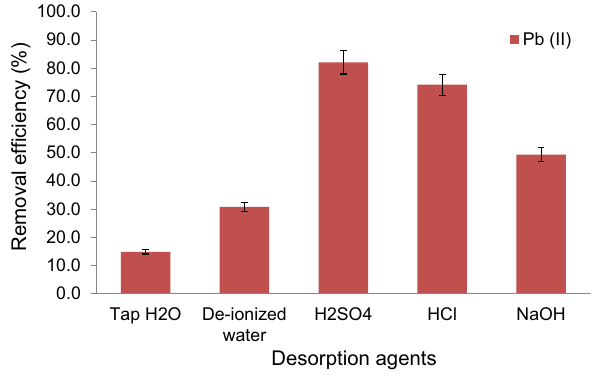
Fig. 2 Desorption of Pb(II) ions adsorbed on groundnut